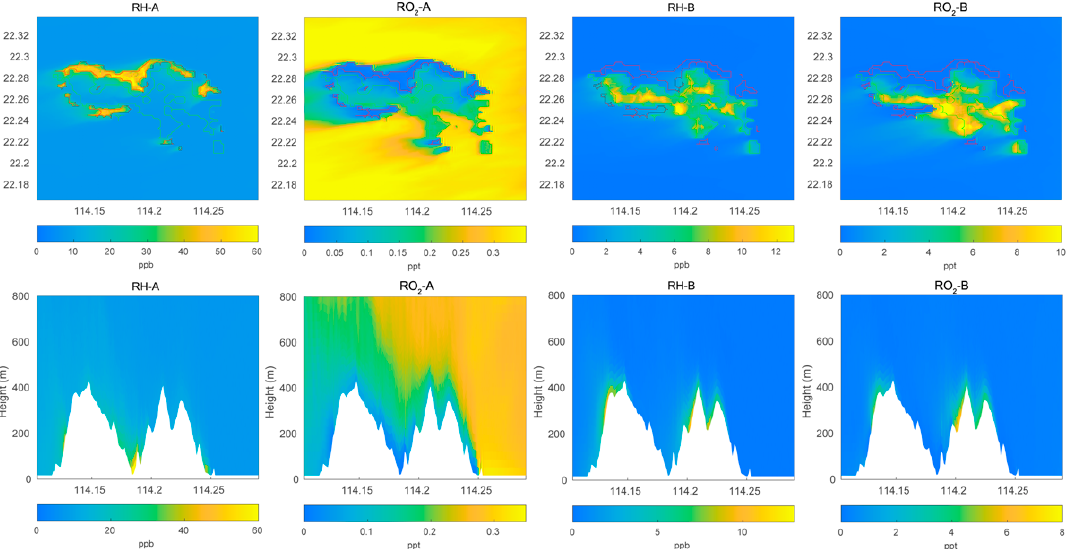
Figure 1. Top panel: horizontal distribution of the surface mixing ratio of primary hydrocarbons RH-A and RH-B and of the corresponding organic peroxy radicals RO 2 -A and RO 2 -B calculated by the LES model for POLLUTED conditions. Lower panel: same as for the top panels, but vertical cross section at latitude 22.275 °N.